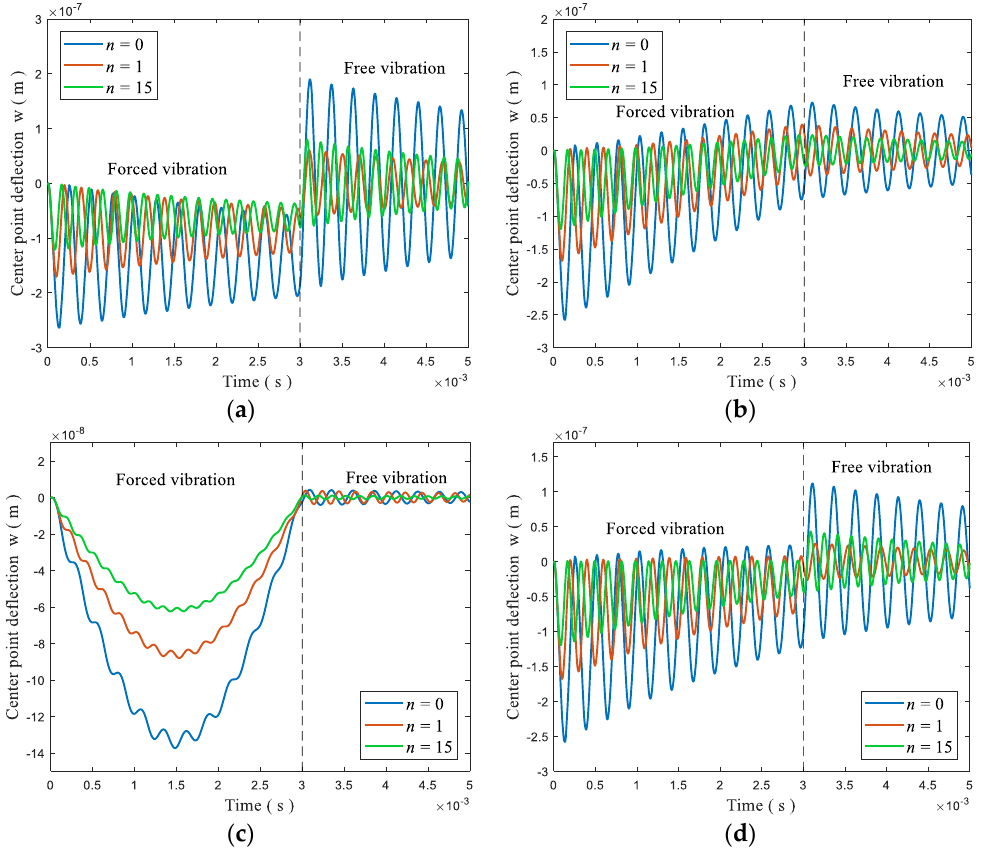
Figure 11. Dynamic analysis of a simply supported (SSSS) PFGP under four different sinusoidally distributed transverse forces: ( a ) Step load; ( b ) triangular load; ( c ) sinusoidal load; ( d ) explosive load.